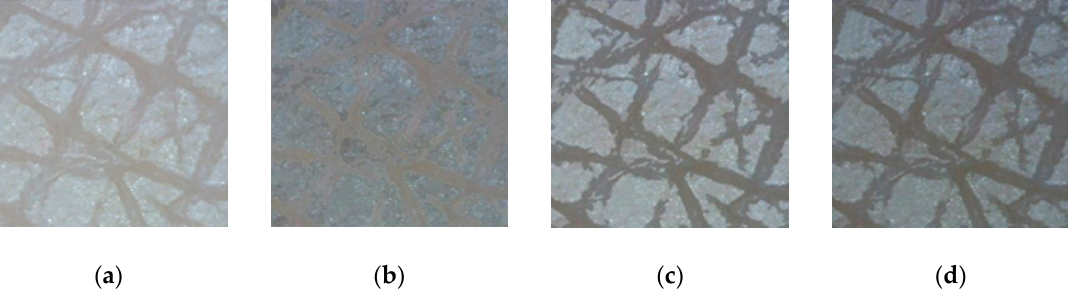
Figure 5. Cell and wrinkle color translation—( a ) original; ( b ) cell color translation; ( c ) wrinkle color translation; ( d ) merged.